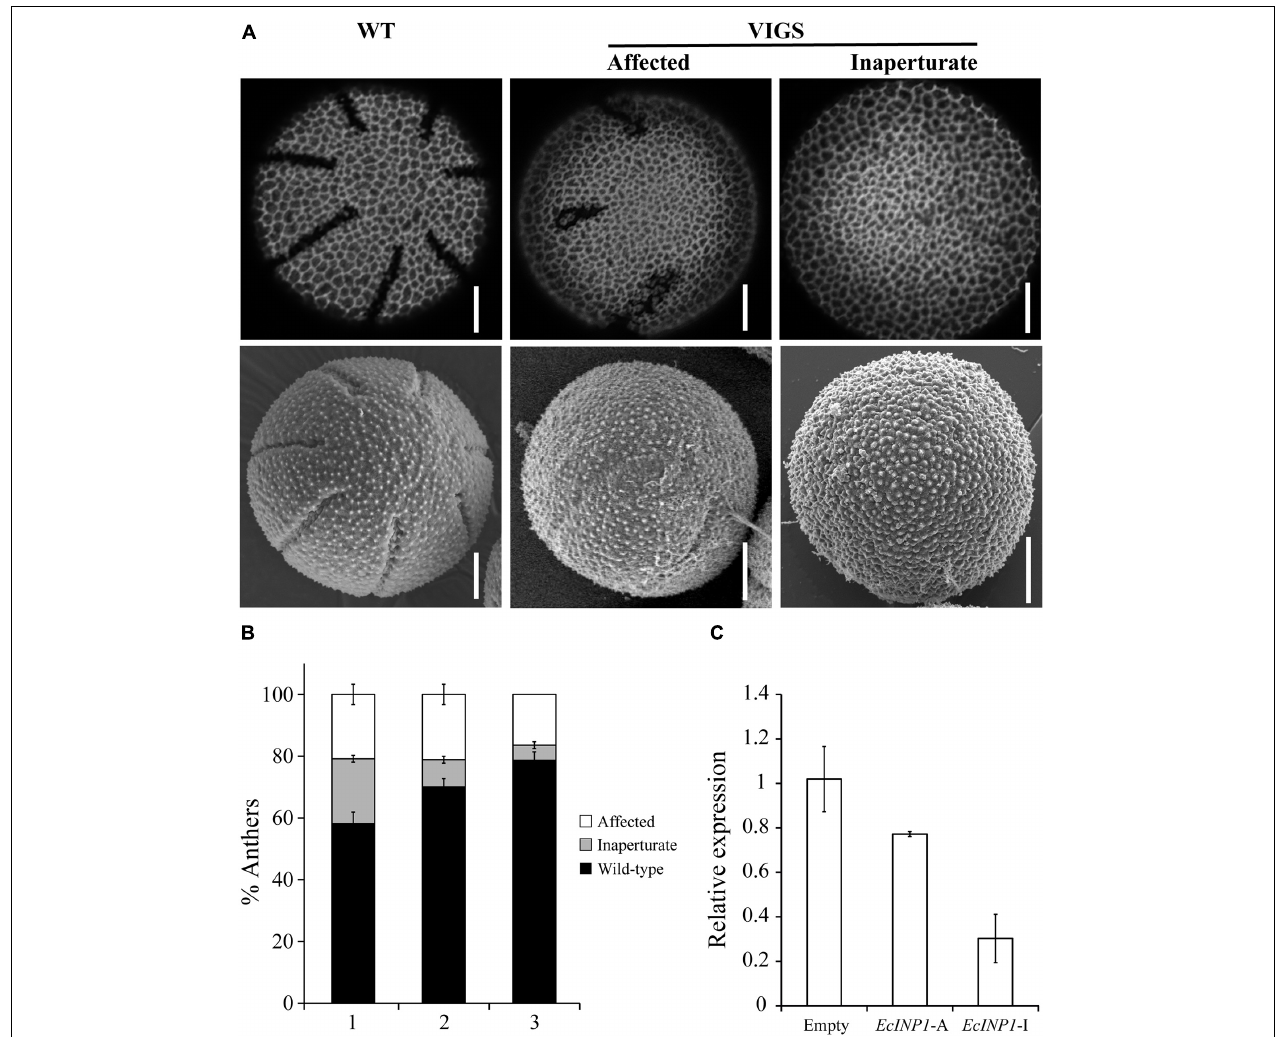
FIGURE 3 | Results of EcINP1 silencing by VIGS. (A) Images showing the observed pollen phenotypes: normal aperturate wild-type (WT), on the left; affected, with shorter and/or shallower apertures, in the middle; inaperturate, on the right. Top images were taken with a confocal microscope and bottom images with a scanning electron microscope. Scale bars = 0.5 µ m (B) Stacked bar plot showing the distribution of observed phenotypes (black: wild-type, gray: inaperturate, white: affected) according to the developmental order of the three flowers (second = (1), third = (2), and fourth = (3)) sampled for each plant treated with pTRV2: EcINP1 . Quantification of phenotypes is shown as the percentage of anthers with pollen of each phenotype, since within each anther all pollen grains showed the same phenotype. (C) Comparison of EcINP1 expression, by qRT-PCR analysis of the first flower bud, in plants treated with pTRV2:empty ( n = 3) and pTRV2: EcINP1 , differentiating between the affected ( EcINP1 -A ; n = 1) and inaperturate ( EcINP1 -I ; n = 3) phenotypes. ANOVA test P -value =